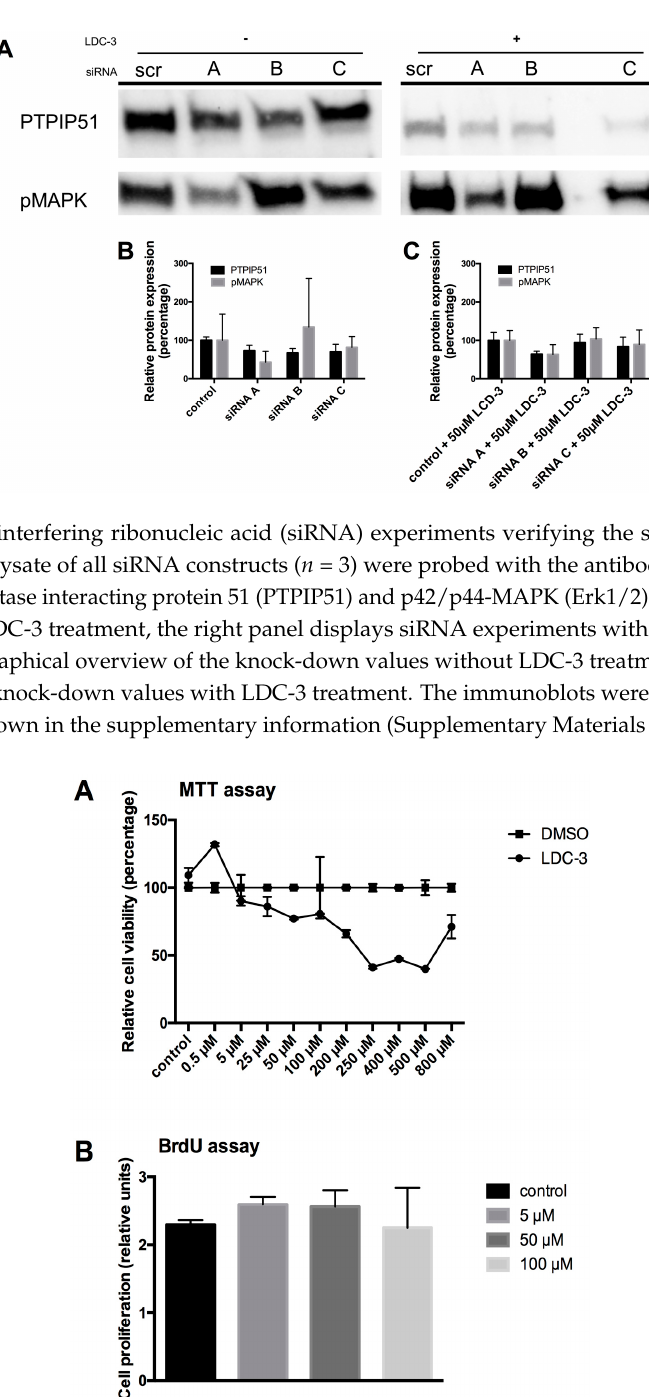
Figure 4. Quantification of total PTPIP51 molecules. ( A ) PTPIP51 protein per cell as determined by Duolink proximity ligation assay (DPLA) using two proximity ligation assay (PLA) probes (plus and minus) both directed against the PTPIP51 antibody in untreated HaCaT cells and cells treated for 24